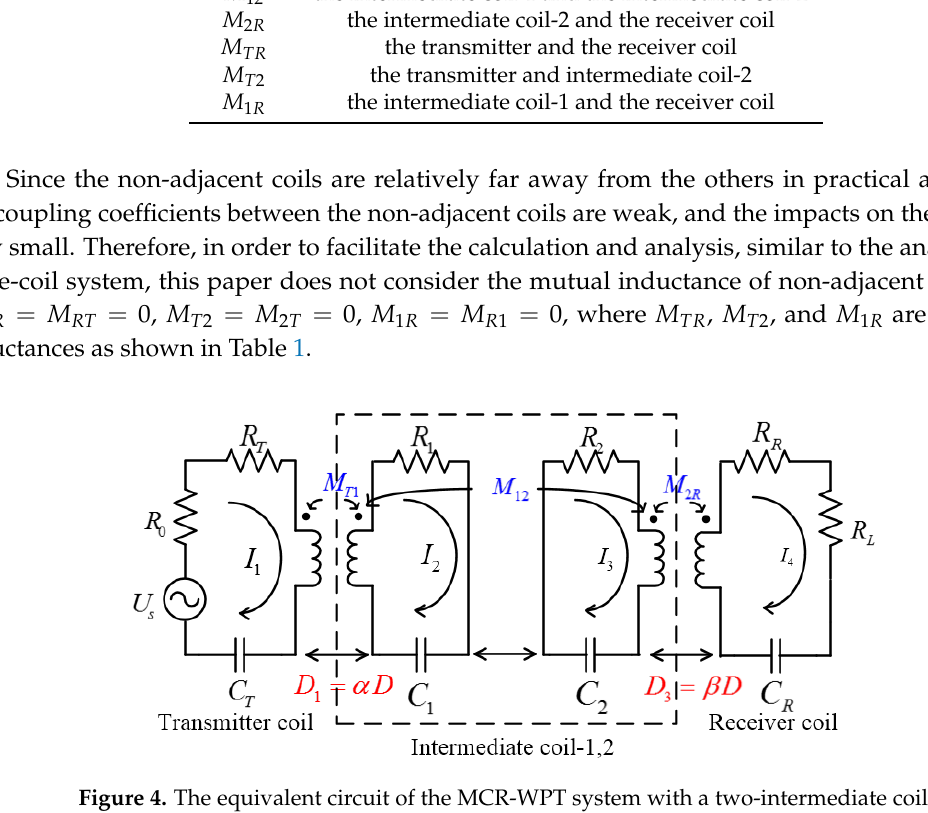
Figure 4. The equivalent circuit of the MCR-WPT system with a two-intermediate